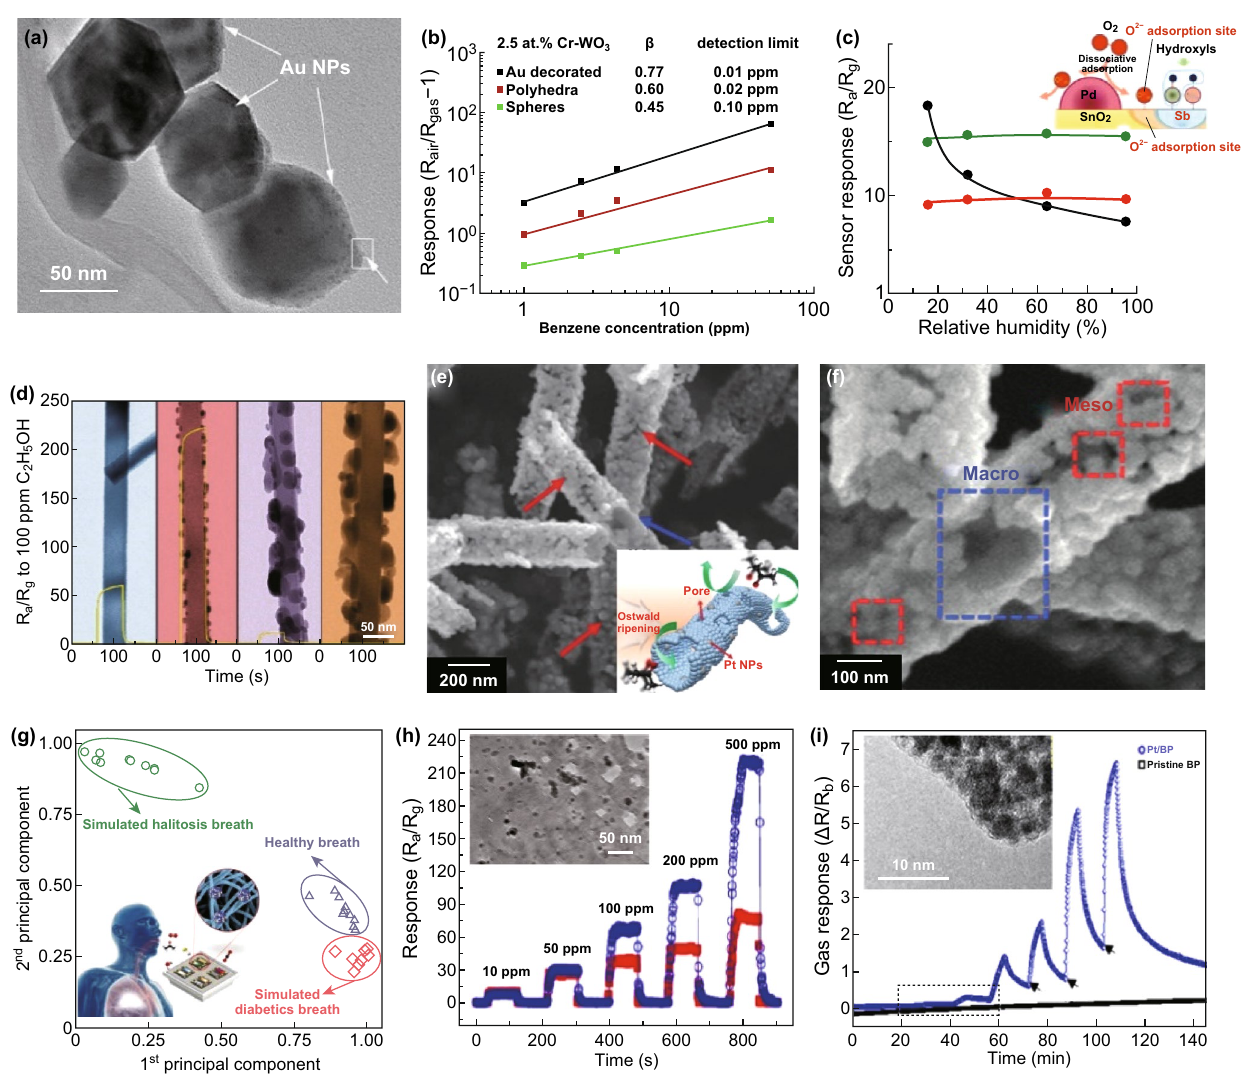
Fig. 3 a SEM images of WO 3 octahedron, b 2.5 at.% Cr–WO 3 truncated octahedron and 10.0 at.% Cr–WO 3 cuboid. Reproduced with permis- sion [50]. Copyright 2015, American Chemical Society. c Humidity dependence of sensor response to 200 ppm hydrogen at 350 °C, using (black) undoped SnO 2 , (red) 0.1 mol % Sb-doped SnO 2 , and (green) 0.1 mol.% Pd-loaded and Sb-doped SnO 2 nanoparticles. Reproduced with permission [89]. Copyright 2016, American Chemical Society. d TEM images of pure SnO 2 , 5Ag–SnO 2 , 10Ag–SnO 2 , and 50Ag–SnO 2 NW after heating at 450 °C for 2 h and the corresponding response-recovery curves to ethanol gas. Reproduced with permission [51]. Copyright 2011, American Chemical Society. e, f SEM images of Pt–PS–SnO 2 NTs (the inset is a schematic illustration). Reproduced with permission [52]. Copyright 2016, Wiley–VCH. g Pattern recognition by PCA using dataset from sensor arrays of PtM-decorated meso-WO 3 NFs evaluating real and simulated (diabetes and halitosis) breath. Reproduced with permission [53]. Copyright 2017, Wiley–VCH. h TEM image of Pd nano- particles@ZnO NSs and the corresponding response-recovery curves to acetone gas (red ZnO NSs). Reproduced with permission [54]. Copy- right 2012, American Chemical Society. i Gas response of Pt/BP and pristine BP to various H 2 concentrations (the inset shows the TEM images of Pt/BP). Reproduced with permission [55]. Copyright 2017, American Chemical Society. (Color figure